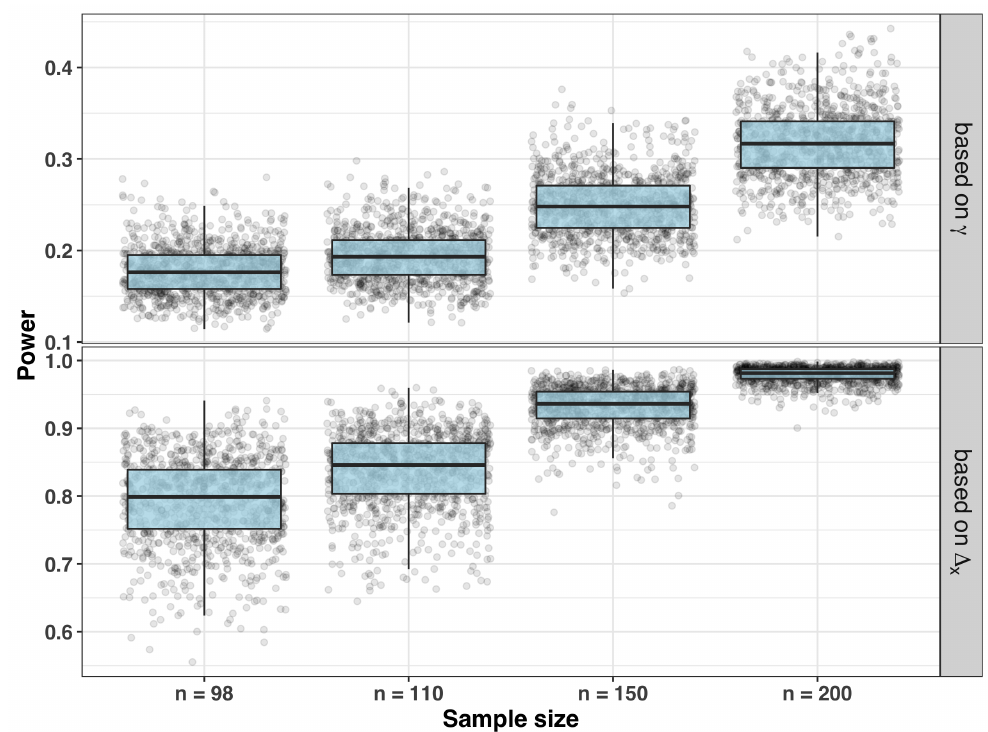
Figure 5. Distributions of power of the test of significance of the slope (top panel) and power of ANCOVA t -test of H 0 : ∆ 0 = 0 (bottom panel). Both tests used a two-sided significance level α = 5% (two-sided). Responses were simulated from the model (1) with µ E = − 1, µ C = 0, γ = − 0.5, and σ = 1. Engagement values were simulated from a normal distribution with mean = 0.6 and SD =